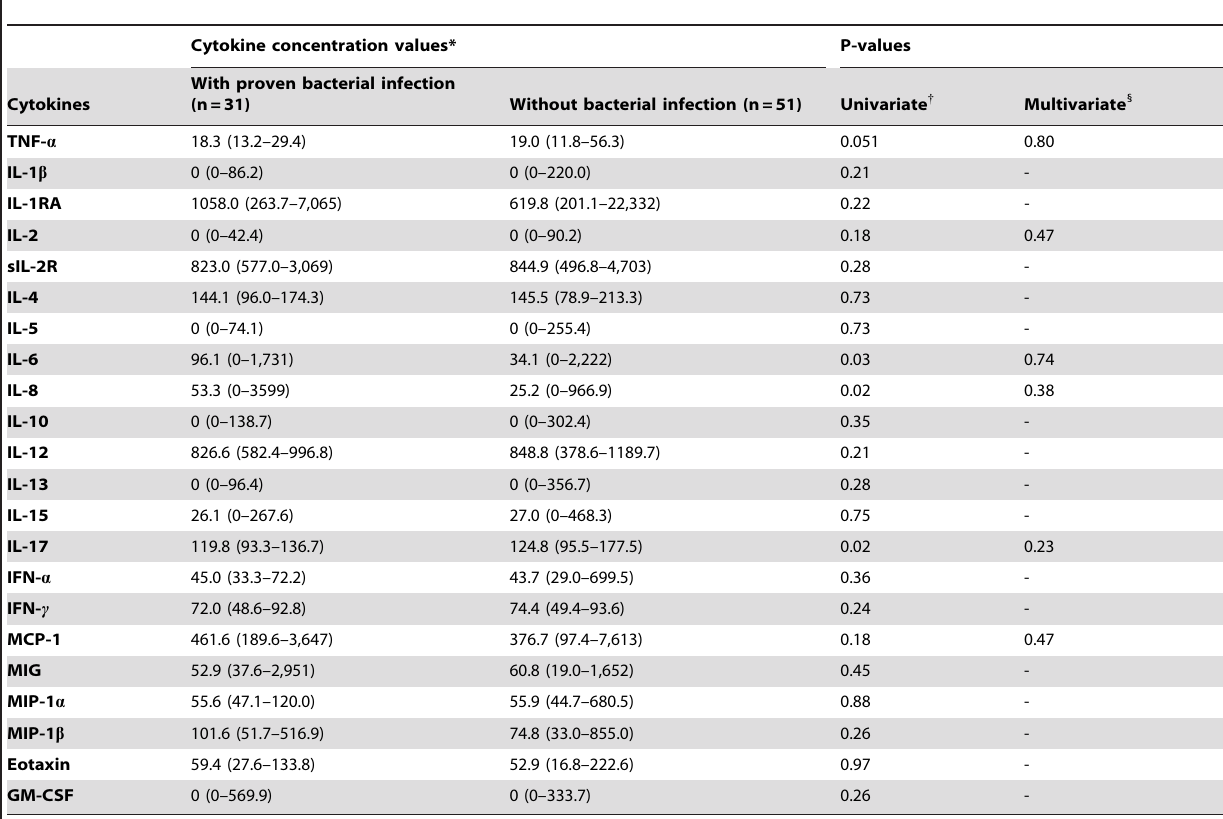
Table 7. Comparison of serum concentrations of cytokines between patients with proven bacterial infection and without bacterial